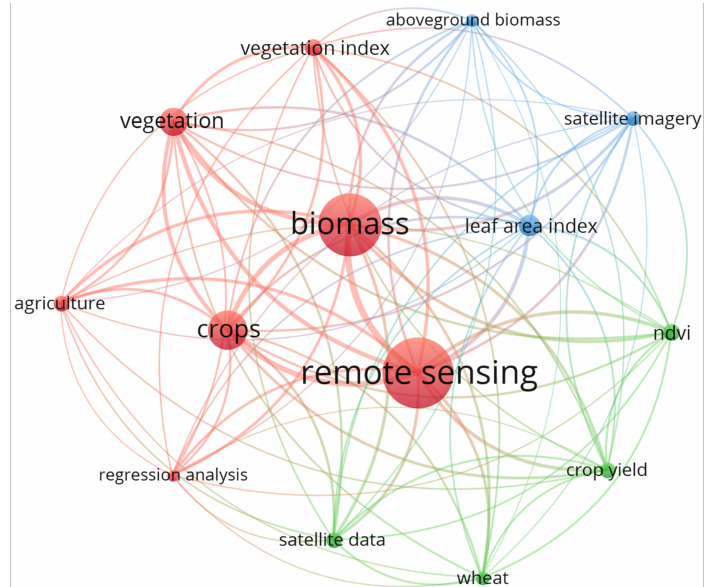
Figure 3. A cloud graphic of frequent terms in journal papers studying crop retrieval using remote sensing. The size of the text reflects the frequency of each specific